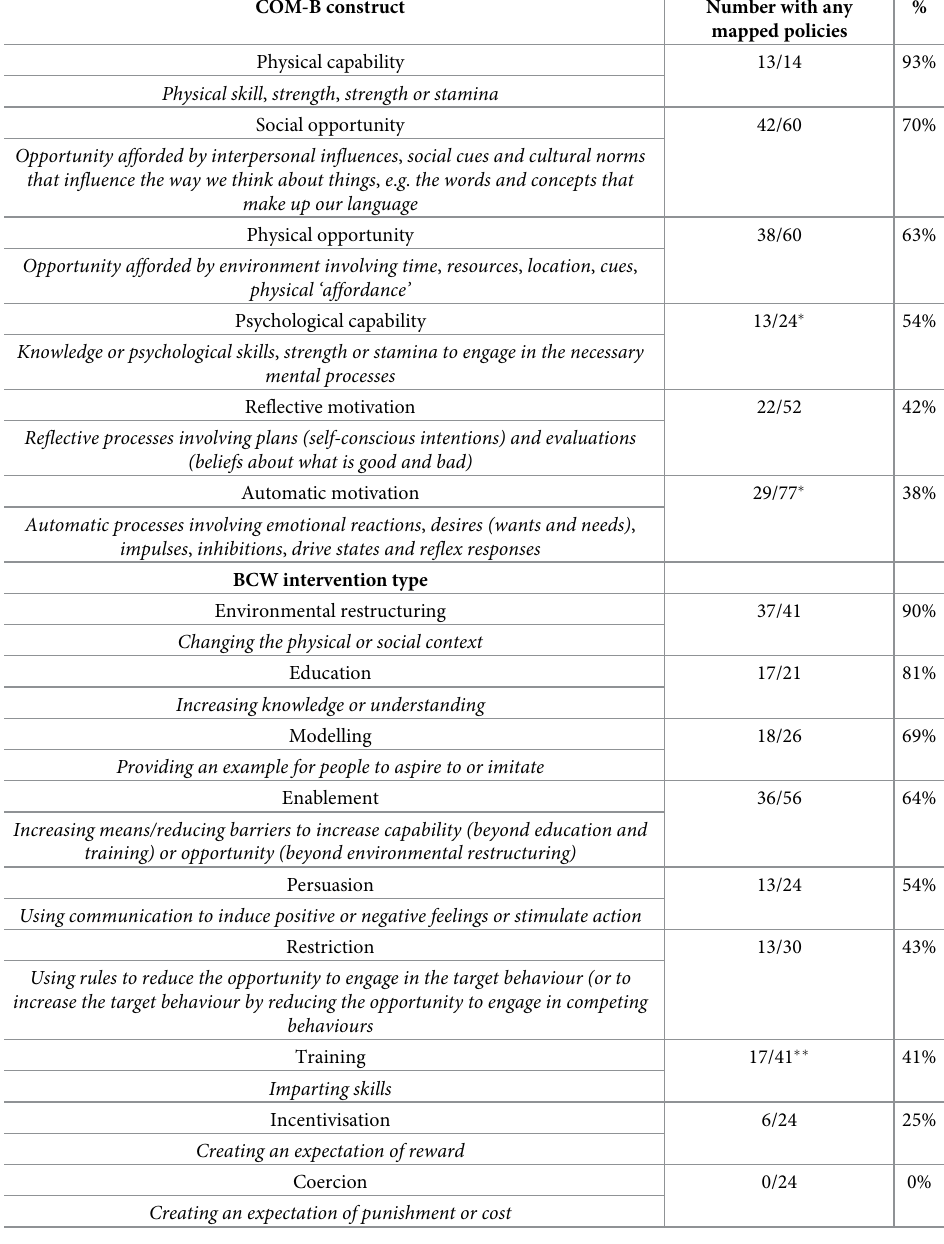
to target physical education and NICE guidance re public open spaces and schools to target advertising, self-esteem, side-effects of drugs, demand for indulgence, and market price of